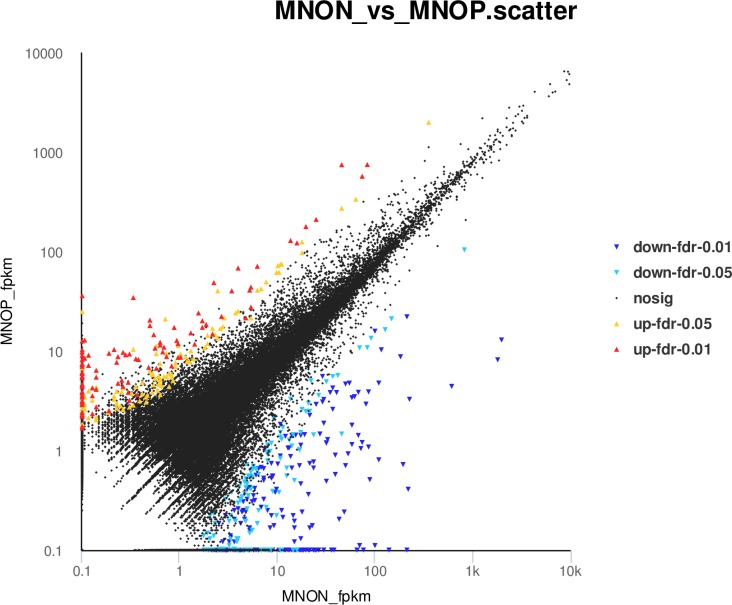
Scatter plot of differentially expressed unigenes (DEGs) between MNOP and MNON.The yellow point (0.01 < fdr < 0.05) and red point (fdr < 0.01) represent significant up-regulated unigenes, the light blue point (0.01 < fdr < 0.05) and dark blue point (fdr < 0.01) represent significant down-regulated unigenes, the black point is no significant difference unigenes.